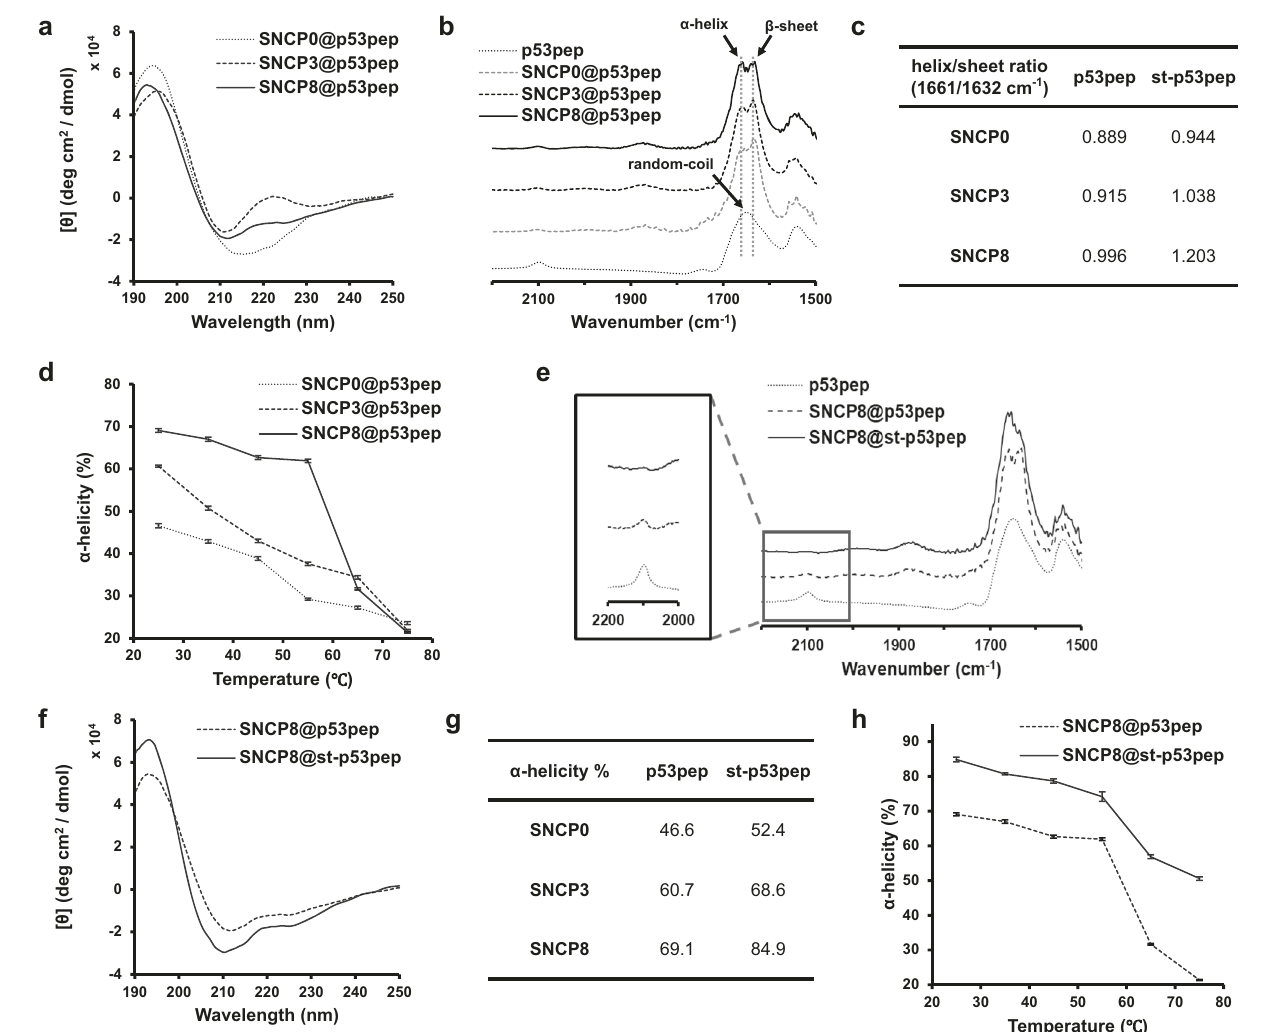
Fig. 3 | Peptide secondary structure analysis. a Circular dichroism (CD) spectra and b Fourier-transforminfrared (FT-IR)spectraof p53pep in SNCPs. c Helix/sheet ratio of p53pep in SNCPs calculated based on the FT-IR spectrum. d α -Helicity of p53pep encapsulated in SNCPs with increasing temperature ( N =3; mean±SD).